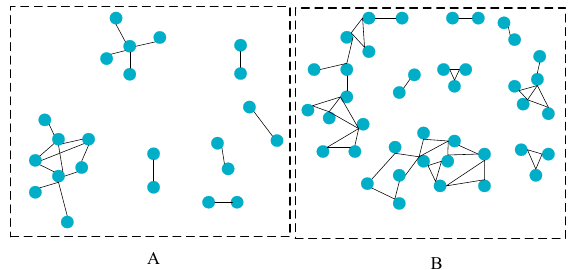
Figure 4. Descriptive statistical results of main variables in sample interval ( A ) Panel E; ( B ) Panel F.